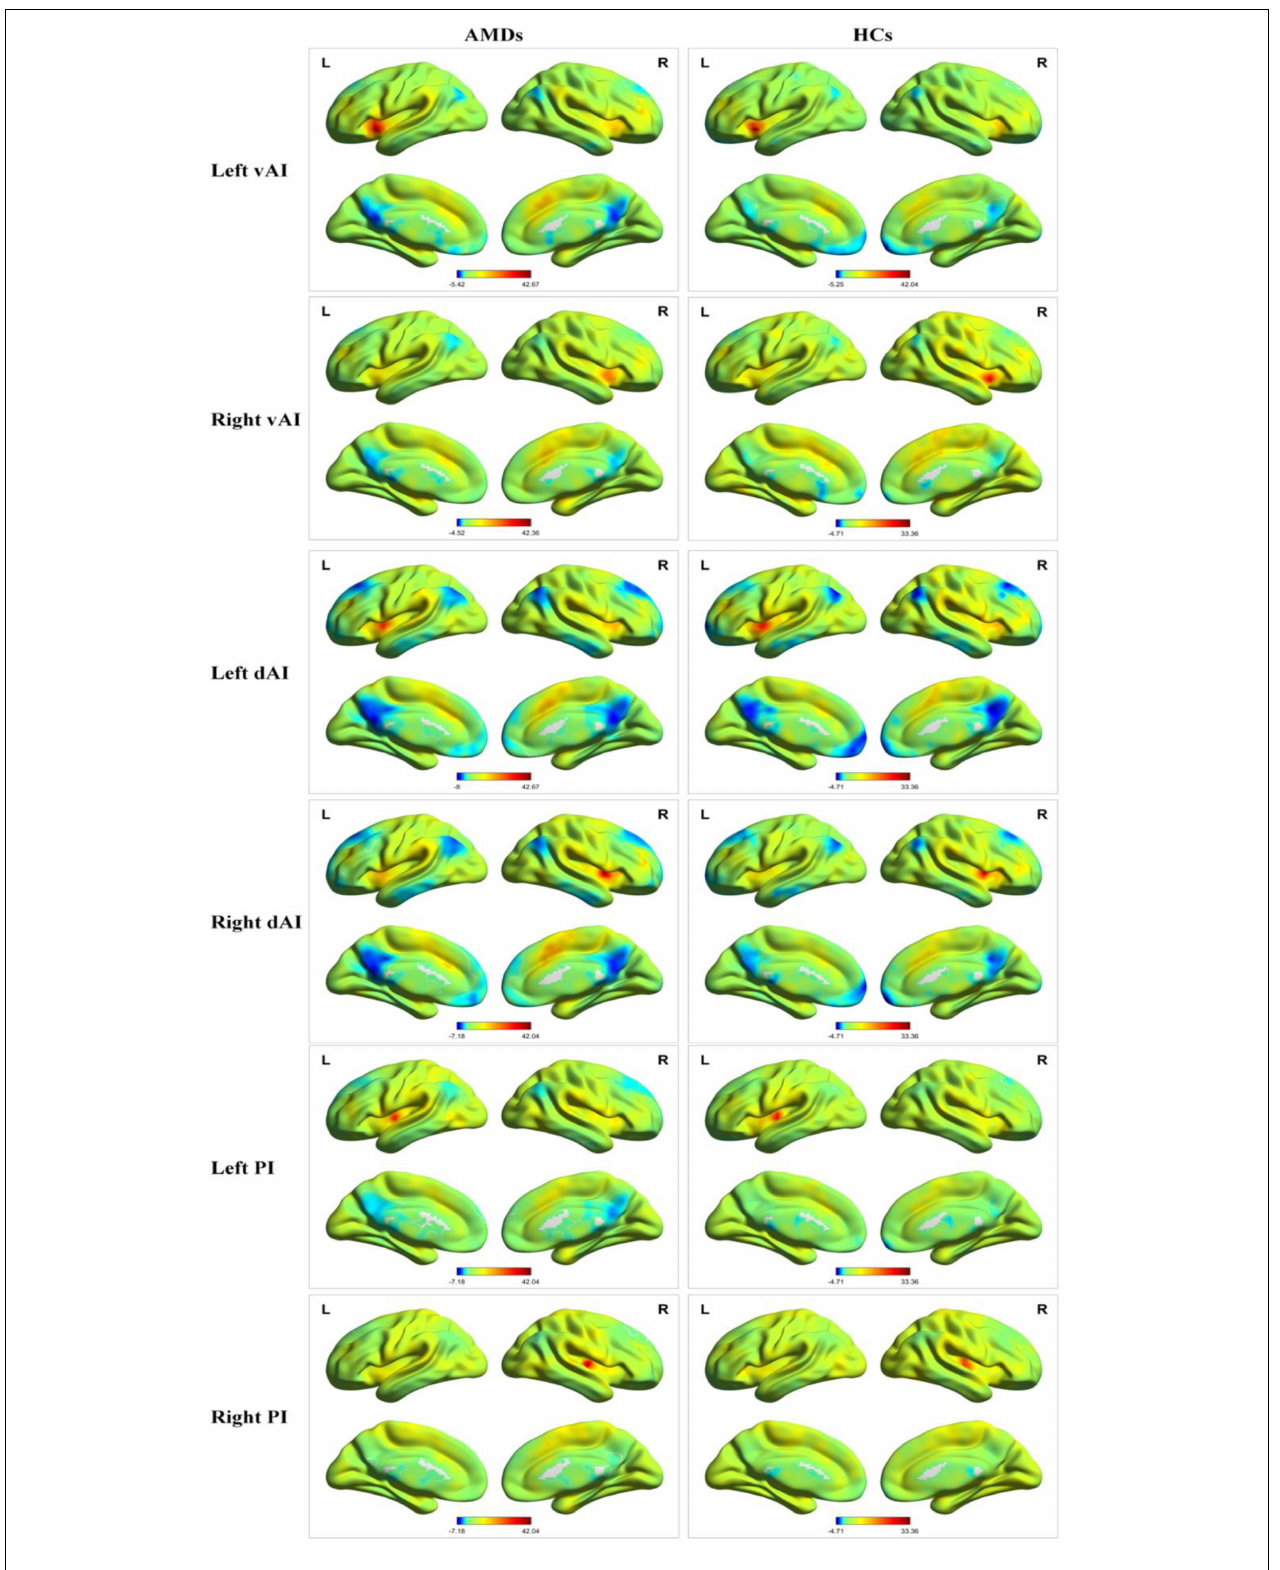
FIGURE 2 | Resting-state functional connectivity patterns of insula subregions in AMDs and HCs. AMDs, age-related macular degeneration group; HCs, healthy controls; vAI, ventral anterior insula; dAI, dorsal anterior insula; PI, posterior insula; L, left; R, right.